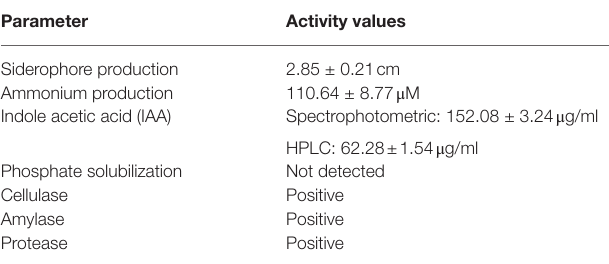
TABLE 1 | In vitro characteristics of Diaporthe strain